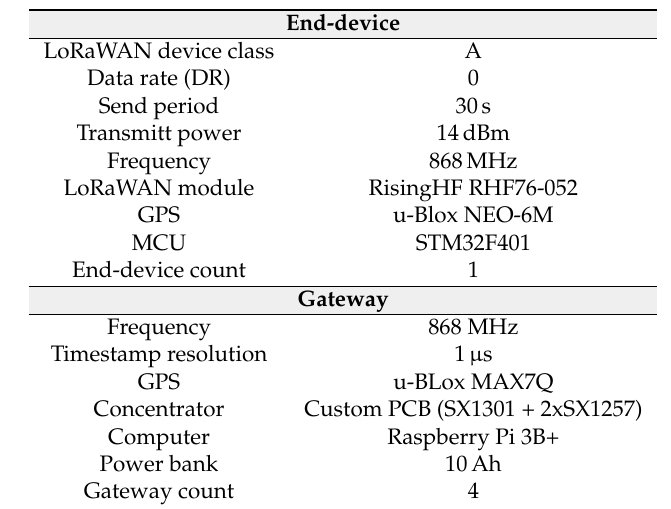
Table 3. Experimental testbed